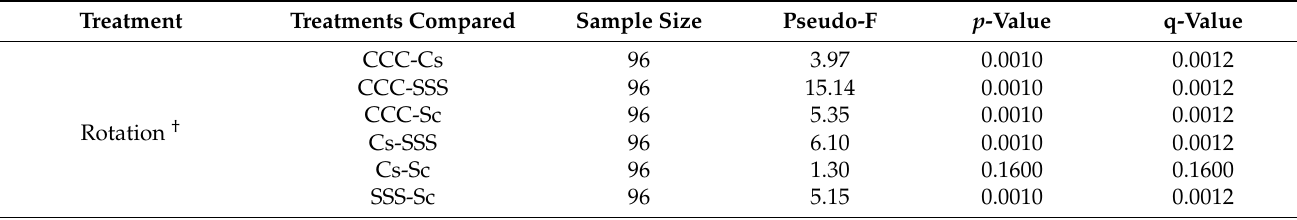
† CCC, continuous corn; Cs, corn phase of the corn-soybean rotation; Sc, soybean phase of the corn-soybean rotation; SSS, continuous soybean. ‡ NT, no-till; T, chisel tillage. Table 2. Community structure ( β -diversity) measures for bacteria following 20 years of crop rotation and tillage treatments, and their interaction, based on pairwise permanova computation of weighted unifrac distances. The pseudo-F column represents the comparison between UniFrac distances for a given treatment combination (listed in the Treatments Compared column). The p -value and q-value columns indicate the probability of type I and type II errors associated with the treatment comparisons,